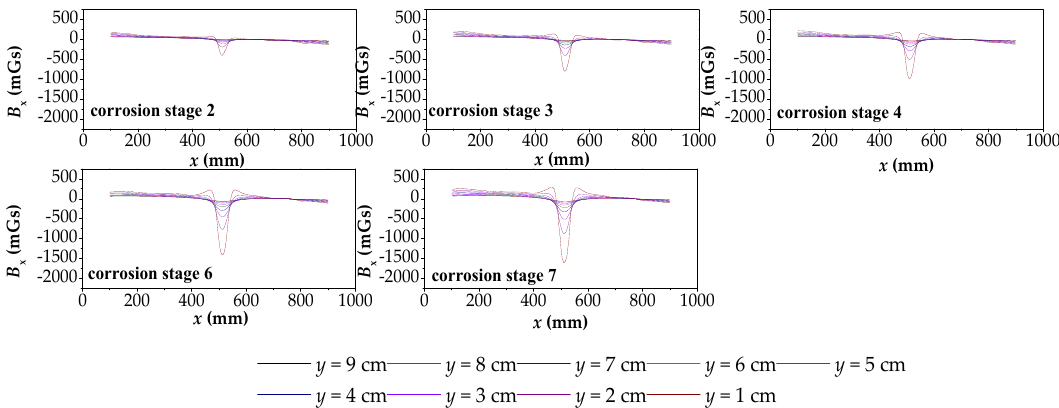
Figure A1. The B x curves of P1 under residual corrosion stages. P1: the parallel wire strand made of seven steel wires; B x : the magnetic flux component of x direction; x : the coordinate along the length of the specimens.